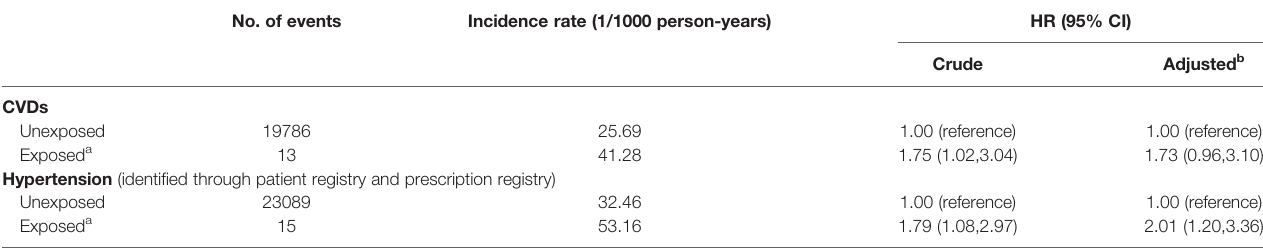
TABLE 4 | Hazard ratios and 95% con fi dence intervals for offspring ’ s CVD according to maternal hypothyroidism during pregnancy in a sibling-matched analysis. No. of